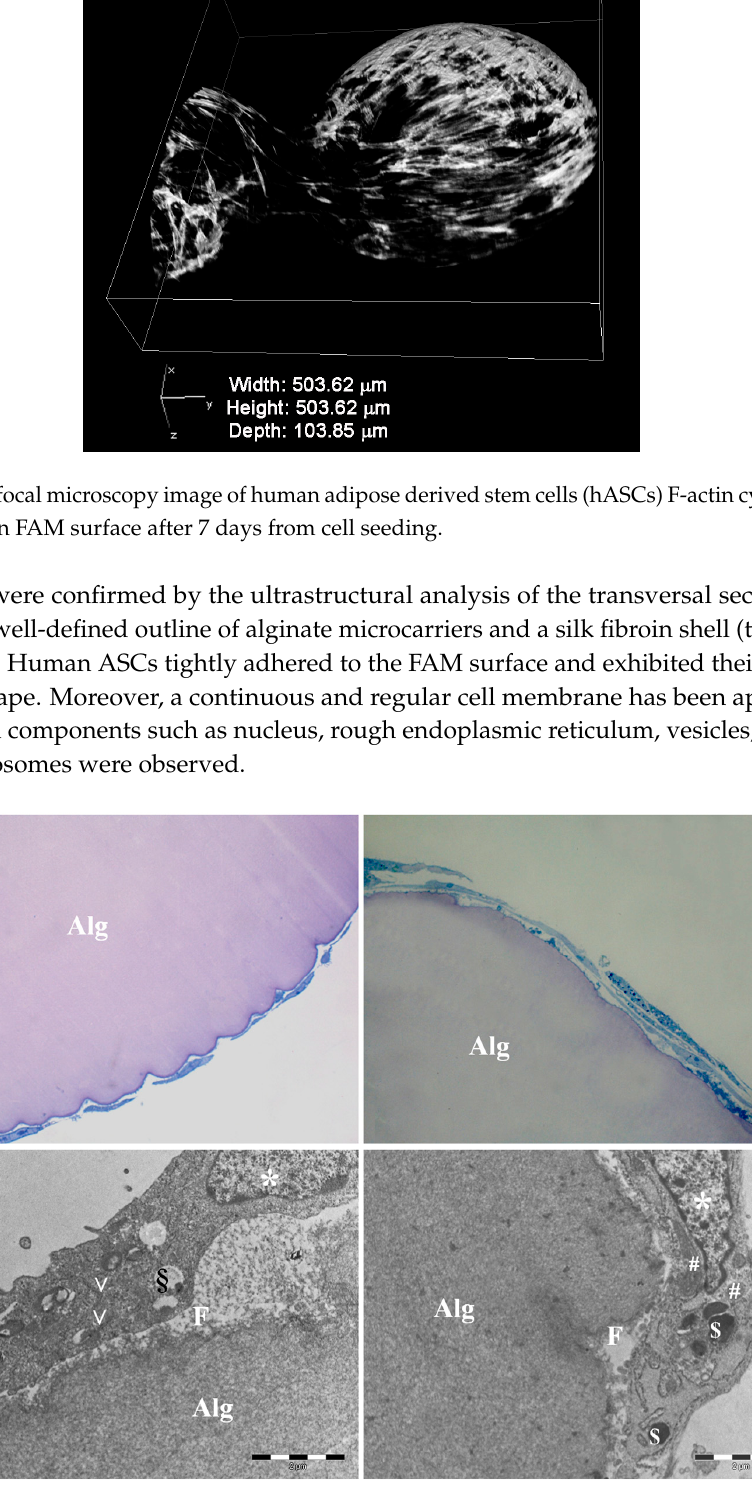
Figure 7. Transversal sections of hASCs cultured on FAMs after 7 ( A , C ) and 14 ( B , D ) days of culture; ( A , B ) light microscopy microphotographs, Toluidine Blue Staining, magnification 20×; ( C , D ) Transmission electron microphotographs, 2 μ m of scale bar: Alg alginate; F fibroin; * nucleus; V rough endoplasmic reticulum; # mitochondria; § vacuoles; $ lysosomes.